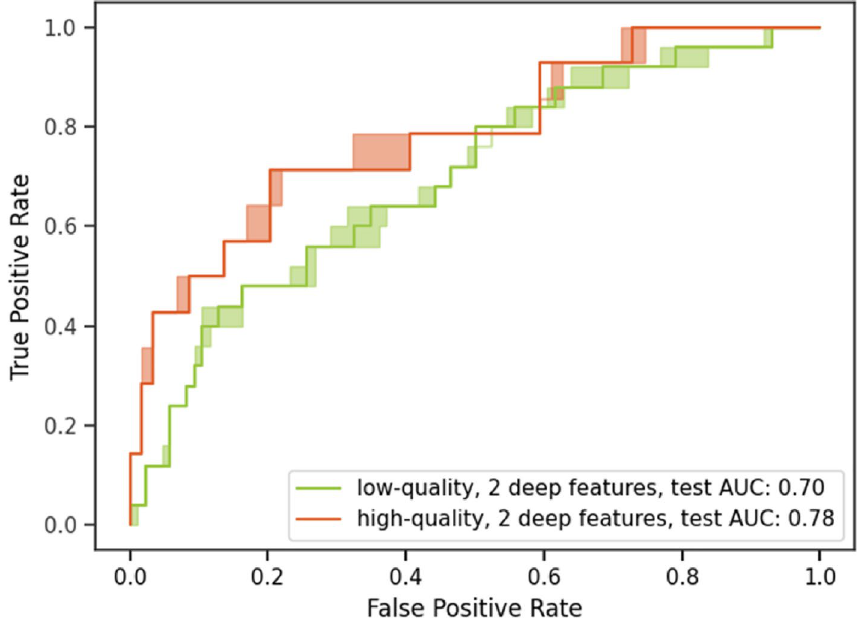
Figure 6. Testing performances of the imaging features on low and high-quality images. The model’s prediction on high-quality images (Score of 6-7) have a slightly higher AUC than on lower quality images.